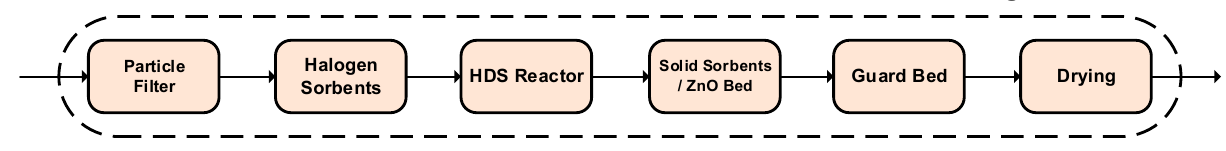
Figure 6. The gas-cleaning scheme.